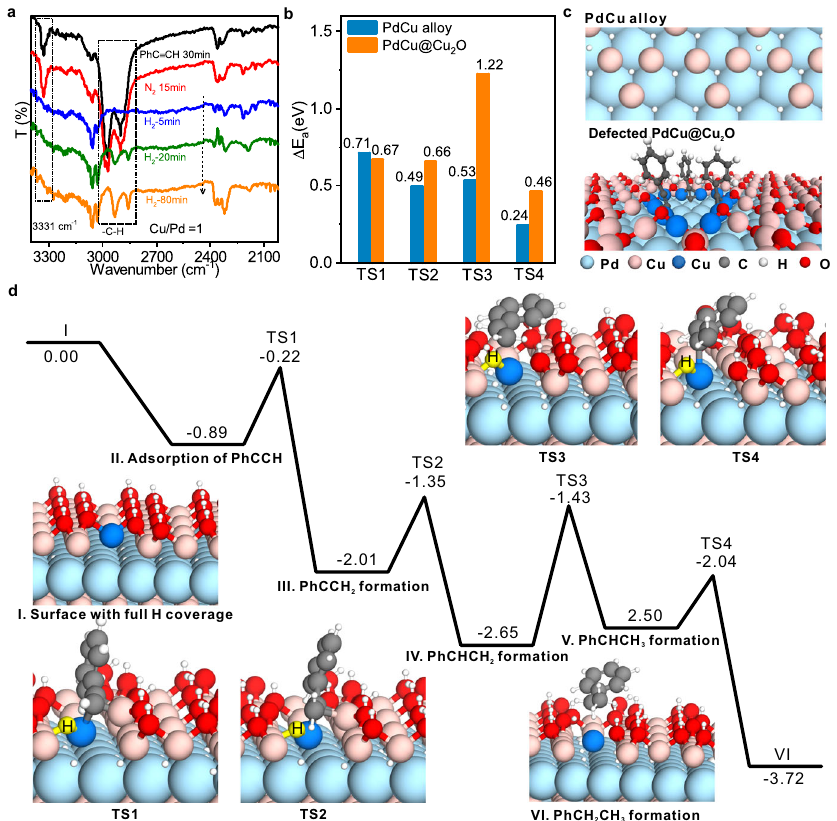
Fig. 3 Mechanism of catalytic hydrogenation on 2D Cu 2 O/Pd interface protected by Cu(I)-C ≡ CPh. a Monitoring the catalytic hydrogenation of PhC ≡ CH on PdCu@Cu 2 O using in situ FT-IR spectroscopy. b Predicted barriers of stepwise hydrogenation of PhC ≡ CH on the reduced PdCu alloy and PdCu@Cu 2 O surface. c DFT-optimized structures of reduced PdCu alloy and defected PdCu@Cu 2 O with dissociated PhC ≡ C − bound on defect sites. d Energy pro fi le of PhC ≡ CH stepwise hydrogenation on PdCu@Cu 2 O surface protected by PhC ≡ CH from DFT